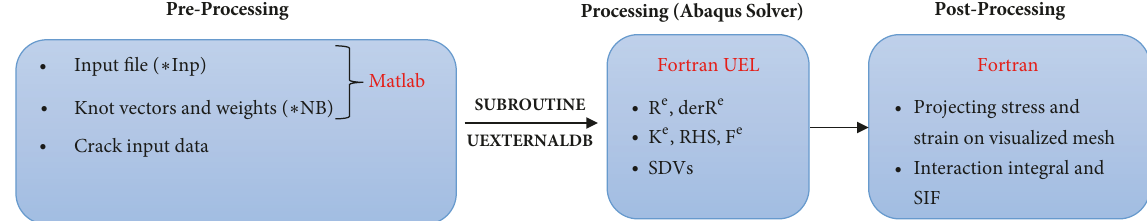
Figure 1: Implementation methodology of X-IGA approach in Abaqus/Standard